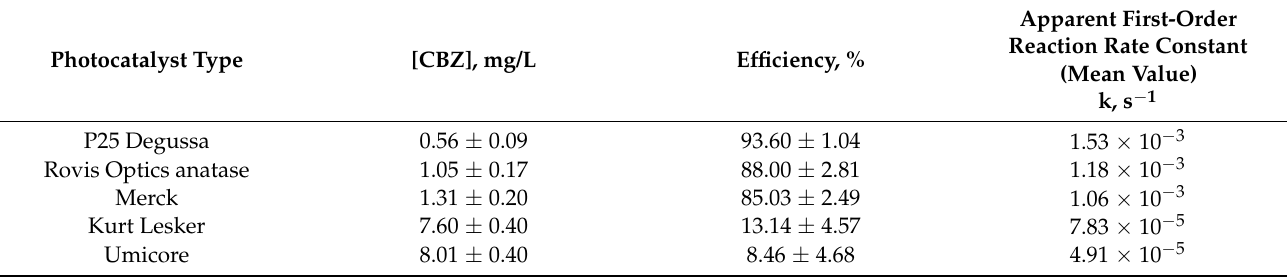
Table 2. CBZ degradation efficiencies obtained using various catalyst types, [CBZ] 0 = 8.75 mg/L